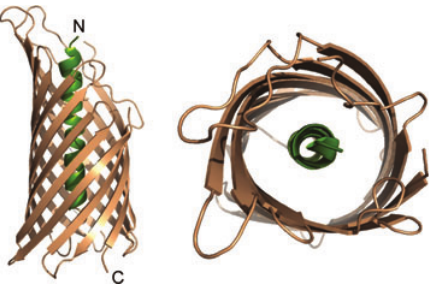
Figure 5 The β -barrel of NalP. A cartoon of the 12-stranded barrel with its narrow pore, roughly 10 Å across, fi lled by the N-terminal α -helix (shown in green). In the panel on the left, the periplasmic face is at the bottom and the outer face is at the top. The model shown is PDB entry 1UYN (53)